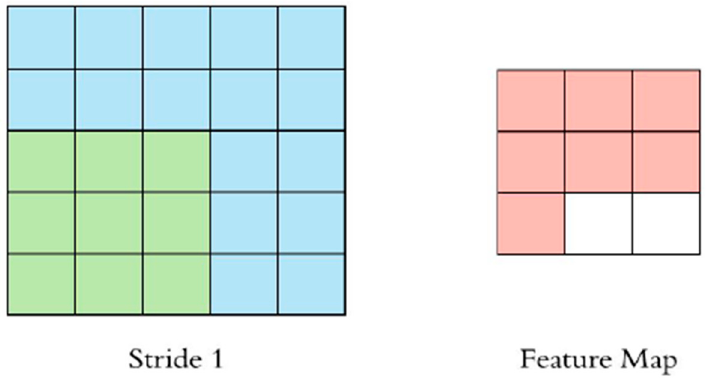
Figure 1. Stride and feature map.